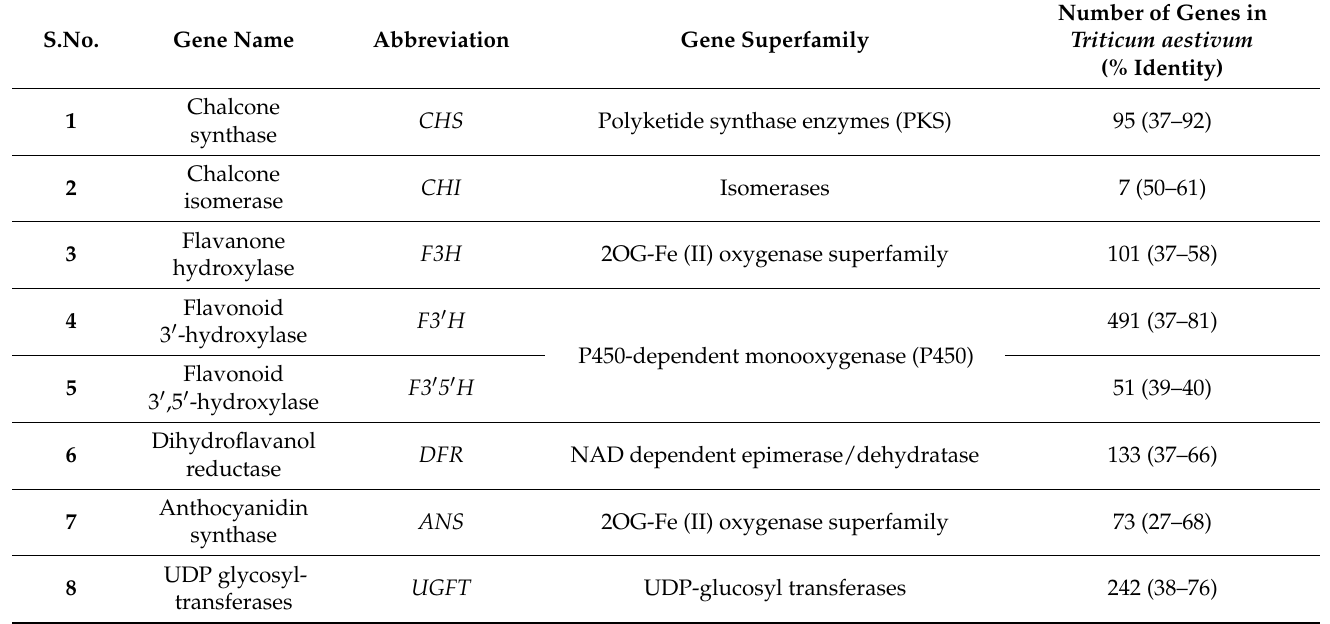
Table 1. Detailed information of putatively identified structural genes of anthocyanin biosynthesis pathway in